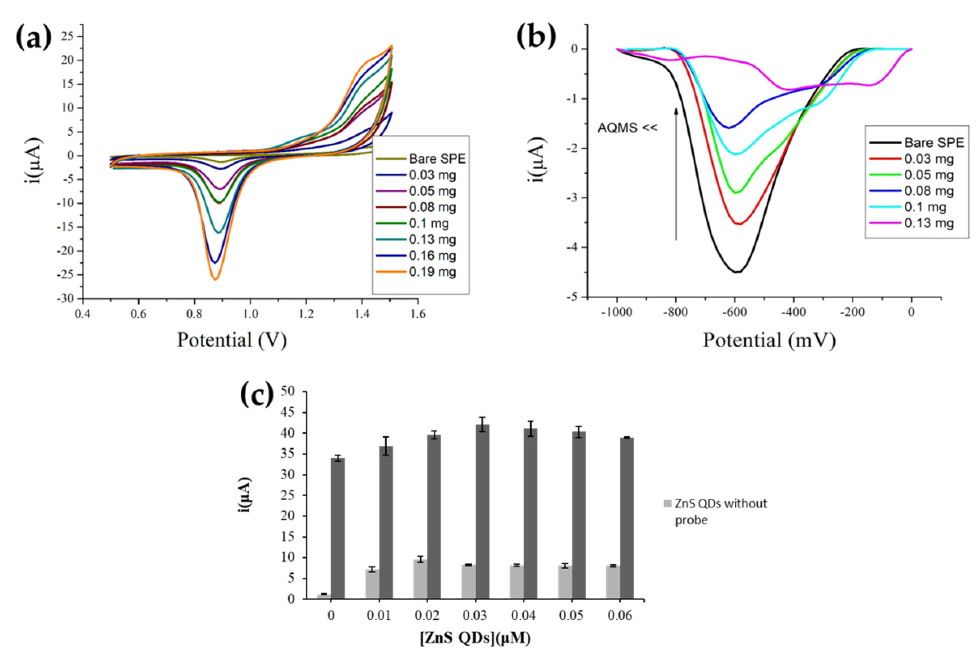
Figure 3. ( a ) The cyclic voltammograms of AuNPs-SPEs with different amounts of immobilized AuNPs. The CV measurement was done in 0.1 M H 2 SO 4 at a scan rate of 100 mVs − 1 . ( b ) The differential pulse voltammograms of AuNPs-SPEs with various AuNPs loadings after exposure to 1 mM AQMS for 1 h. The DPV measurement was conducted in 0.01 M PBS (pH 7) containing 0.1 M KCl at a scan rate of 100 mVs − 1 . ( c ) The DPV responses of MPA-ZnS QDs/AuNPs-SPE and DNA biosensor at different immobilized MPA-ZnS QDs amounts. The DPV measurements were carried out in 0.01 M PBS (pH 7) containing 0.1 M KCl and 1 mM AQMS for MPA-ZnS QDs/AuNPs-SPE and 0.01 M PBS (pH 7) containing 0.1 M KCl for DNA biosensor at the scan rate of 100 mVs − 1 .